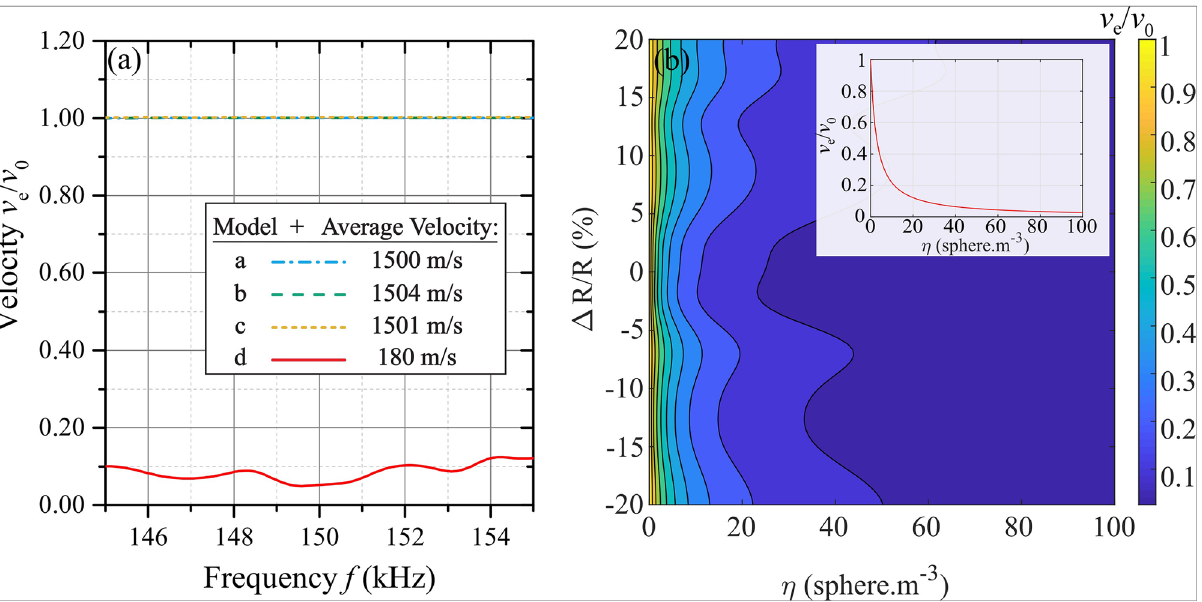
Figure 3. ( a ) Normalized velocity v e / v 0 calculations versus frequency for the four different models (see the legend for the average value over this frequency range of the energy velocity for each model). ( b ) Normalized velocity v e / v 0 calculations versus fish size variation � R / R and concentration η at a given frequency f for model d. The inset represents v e / v 0 versus fish concentration for � R / R = 0 and f